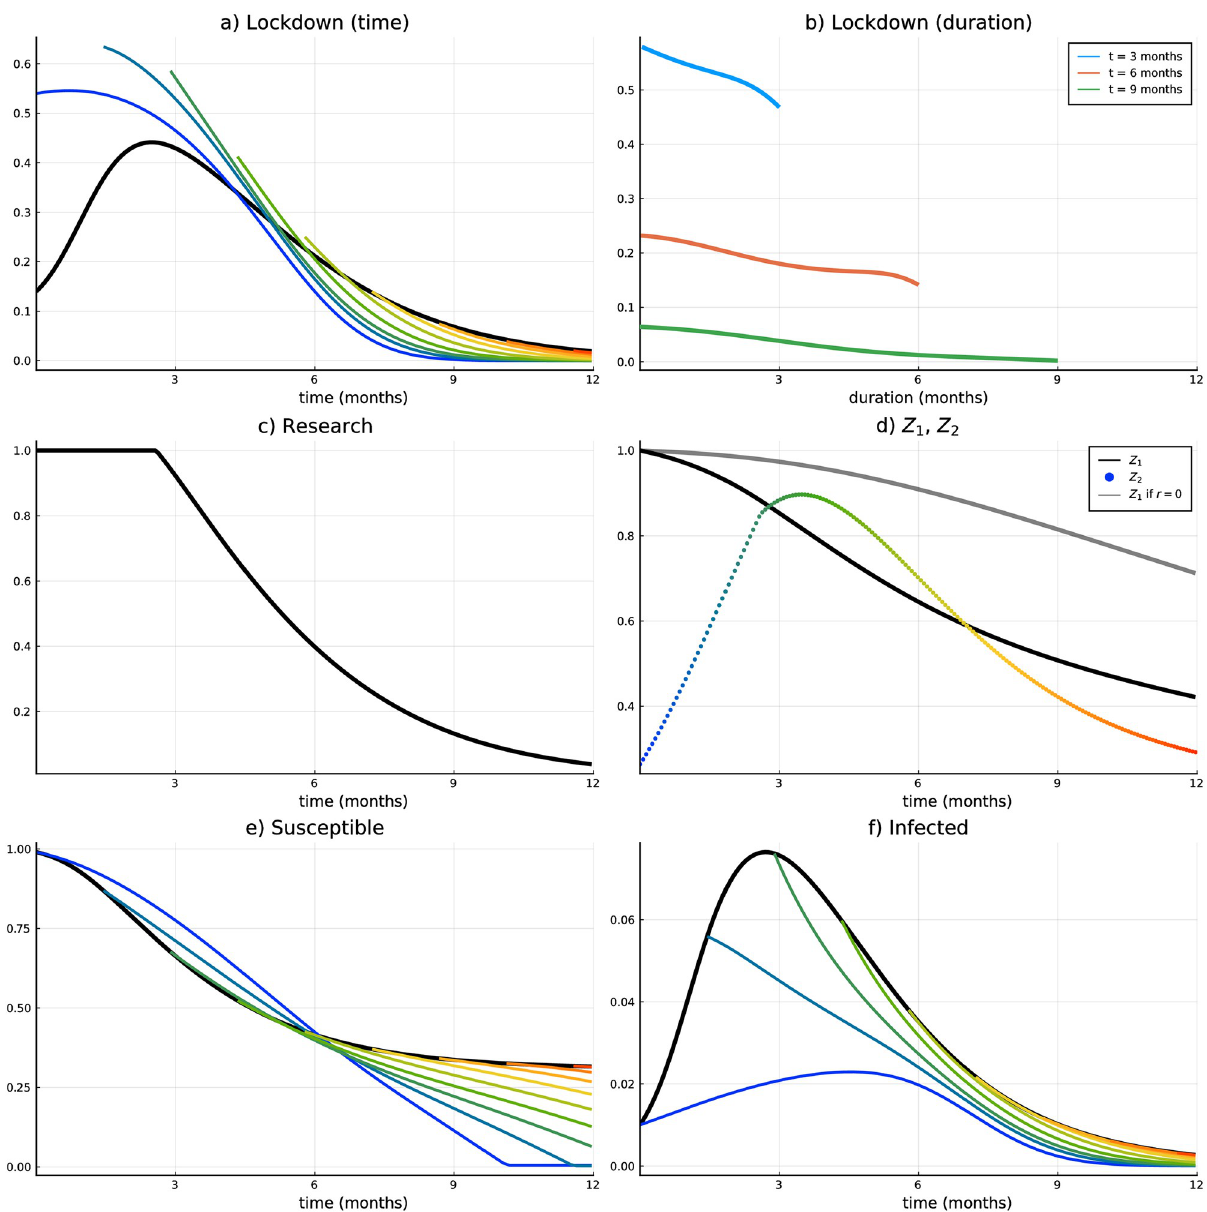
Fig 4. Scenario 1 (Course of the pandemic). (a) Lockdown intensity over time, (b) Lockdown intensity along duration, (c) Research effort over time, (d) Probability that τ has not set in yet, (e) Susceptibles, (f) Infected.